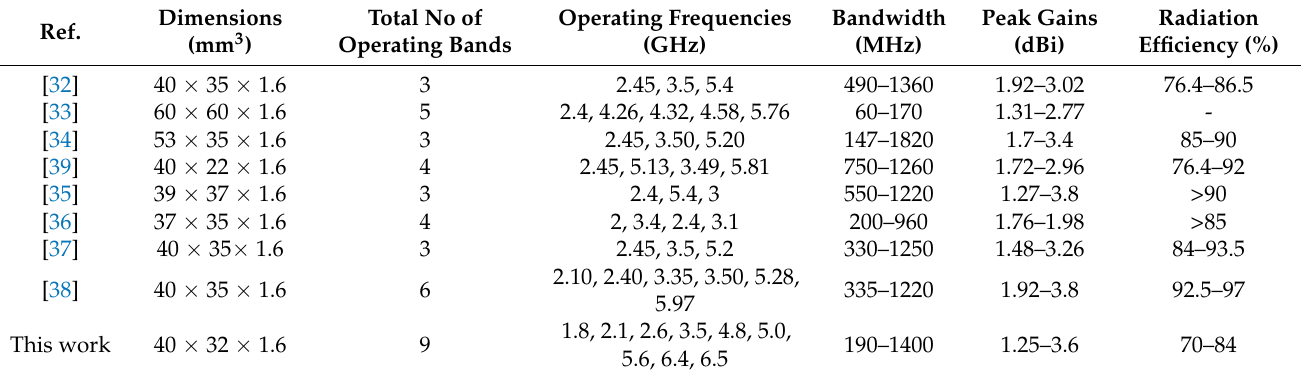
Table 5. Proposed antenna’s comparison with other reported